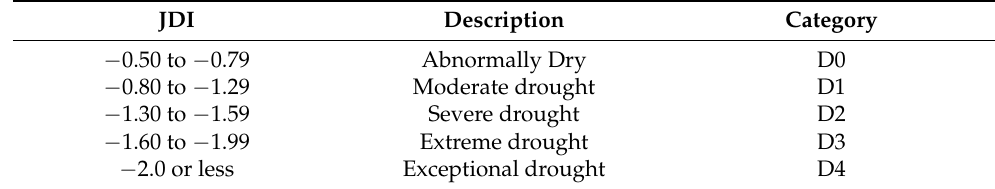
Table 1. Drought classification categories and description with respect to JDI intensities.